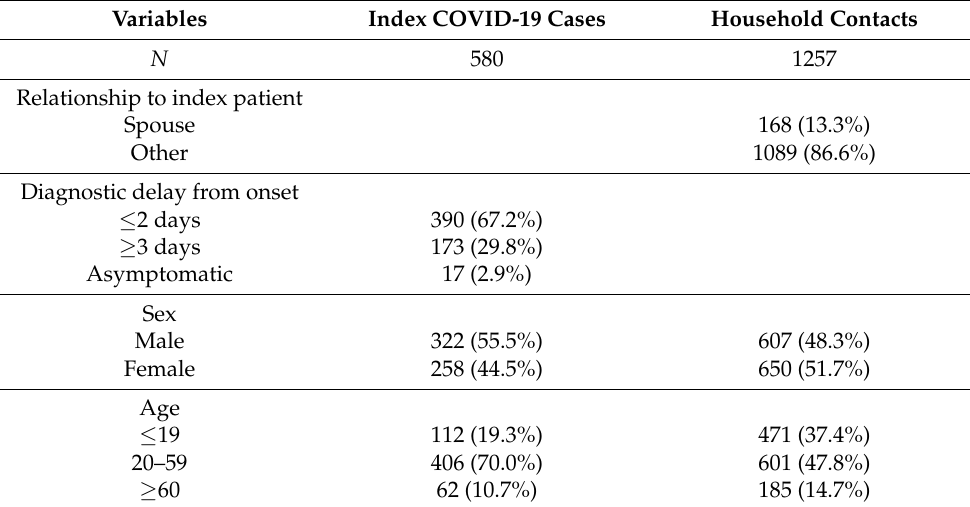
Table 2. Characteristics of COVID-19 patients, and unvaccinated household